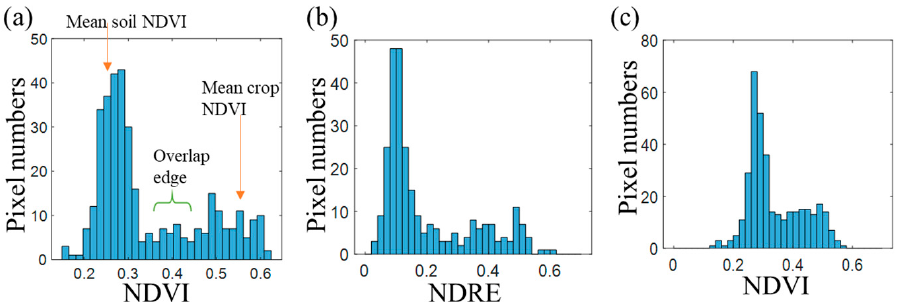
Figure 5. Image histograms of three example indices. ( a ) NDVI calculated using bands at 841 nm and 667 nm, which had large di ff erence between mean soil NDVI and crop NDVI and had small overlap between the edge of soil NDVI and crops NDVI. ( b ) NDRE calculated using bands at 841 nm and 716 m. ( c ) NDVI calculated using bands at 900 nm and 667 nm.